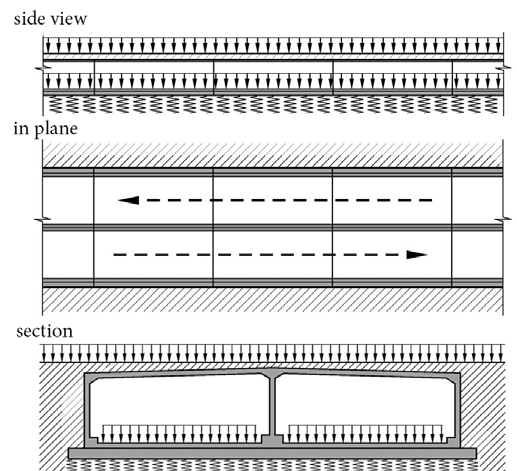
fig. 1. General views of the road